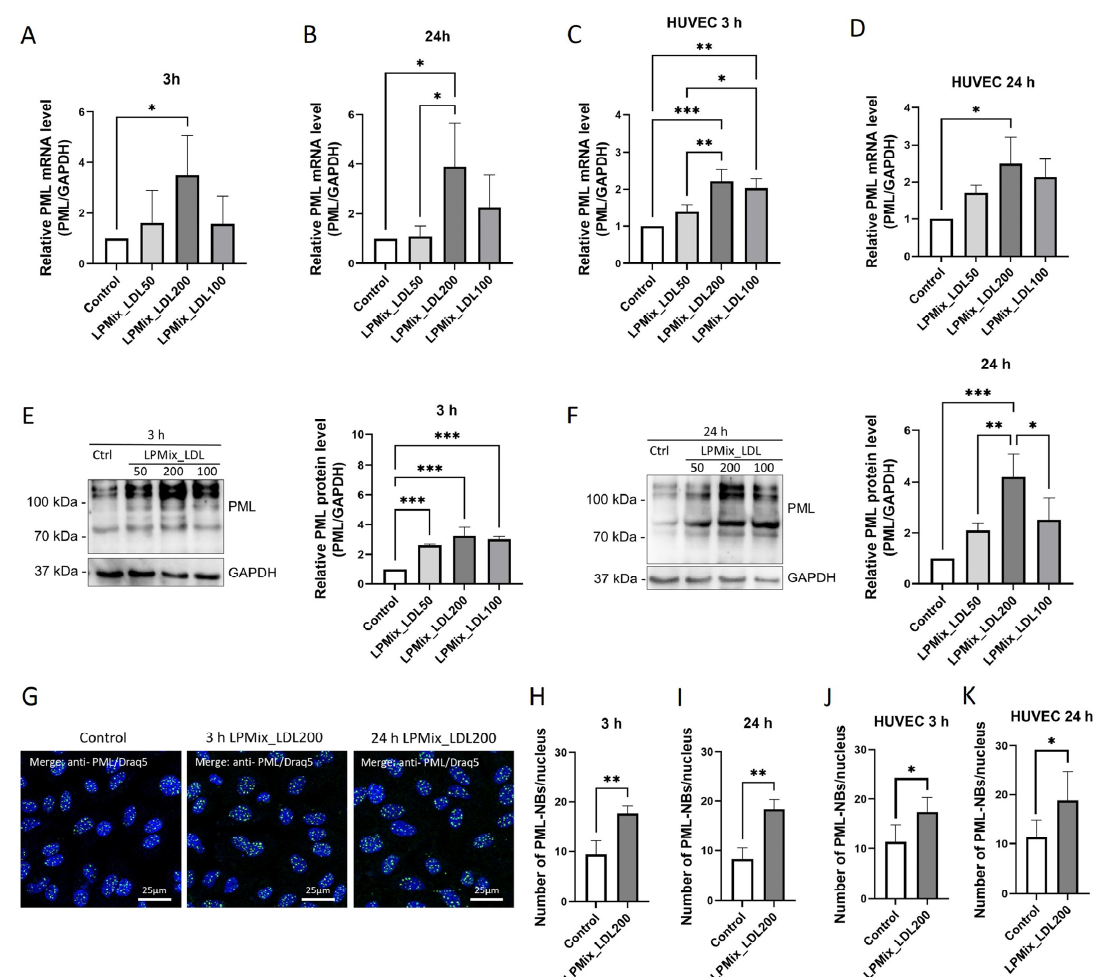
Figure 2. LDL added to lipoprotein mixtures dose-dependently regulates PML expression and PML- NB assembly in endothelial cells. ( A – D ) PML mRNA levels in EA.hy926 cells ( A , B ) or HUVECs ( C , D ) were quantified using RT-qPCR after incubation with LPMix supplemented with LDL in different concentrations for 3 h ( A , C ) or 24 h ( B , D ). Expression values relative to controls. n = 4, one-way ANOVA. ( E , F ) Immunoblotting on total lysates of EA.hy926 cells incubated with LPMix supplemented with LDL in different concentrations for 3 h ( E ) or 24 h ( F ). Expression values relative to controls. Representative immunoblots of n = 4, one-way ANOVA. ( G ) Immunocytochemistry with an anti-PML (green) antibody on EA.hy926 cells incubated with high concentrations of LDL (200 mg/dL) for 3 h or 24 h. Draq5 staining for labeling of cell nuclei (blue). Representative images of n = 3 experiments. ( H – K ) Number of PML-NBs per nucleus in EA.hy926 cells ( H , I ) or HUVECs ( J , K ) incubated with LPMix supplemented with high concentrations of LDL for 3 h ( H , J ) or 24 h ( I , K ). n = 3 Student’s t -tests. All graphs shown as mean ± SD, * p < 0.05, ** p < 0.01, *** p <